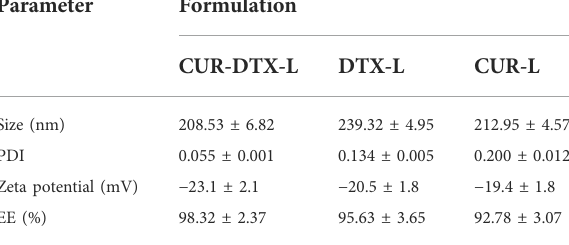
TABLE 1 Characterization of different formulations ( n =